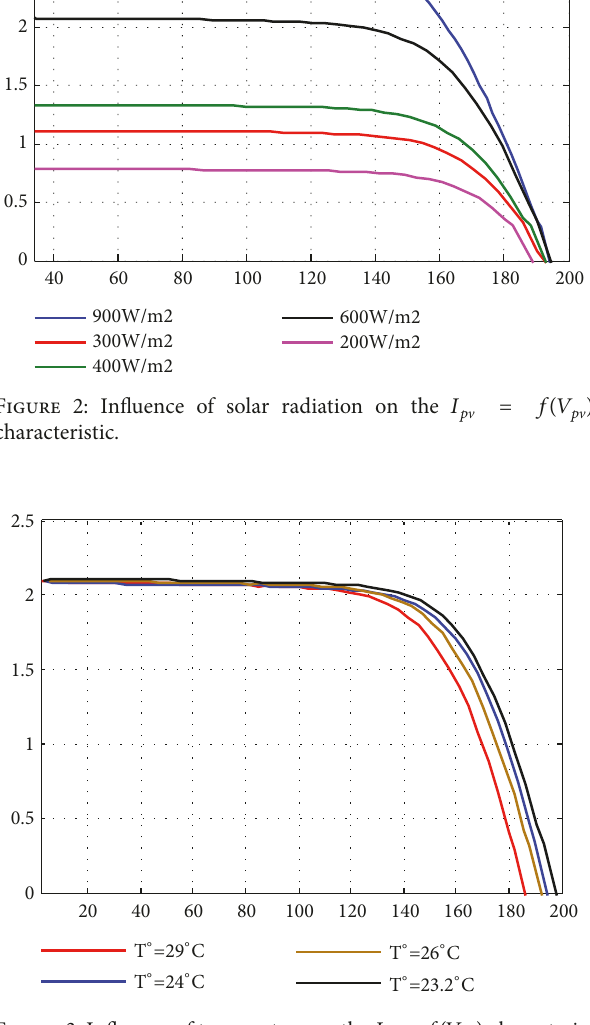
Figure 3: Influence of temperature on the 𝐼 𝑝 V = 𝑓(𝑉 𝑝 V ) characteris- tic.